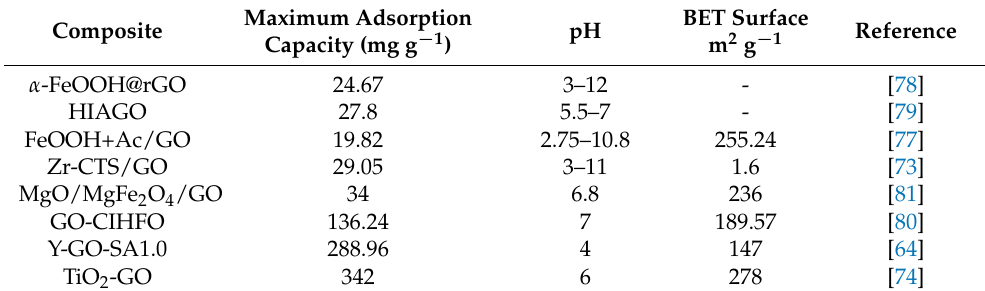
Table 2. Fluoride adsorption on composites of